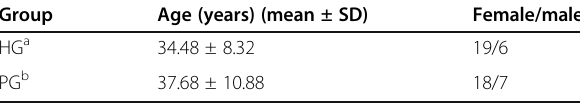
Table 1 Demographic characteristics of participants